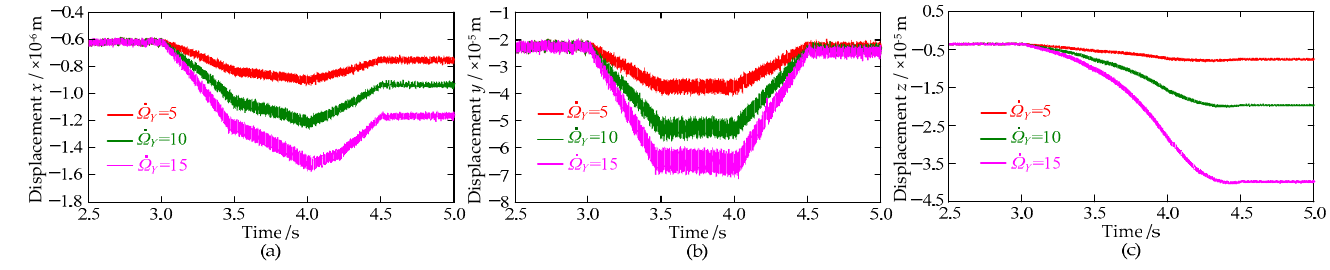
Figure 19. Displacement responses of node 14 under different rotating accelerations: ( a ) x -direction; ( b ) y -direction; ( c ) z -direction.